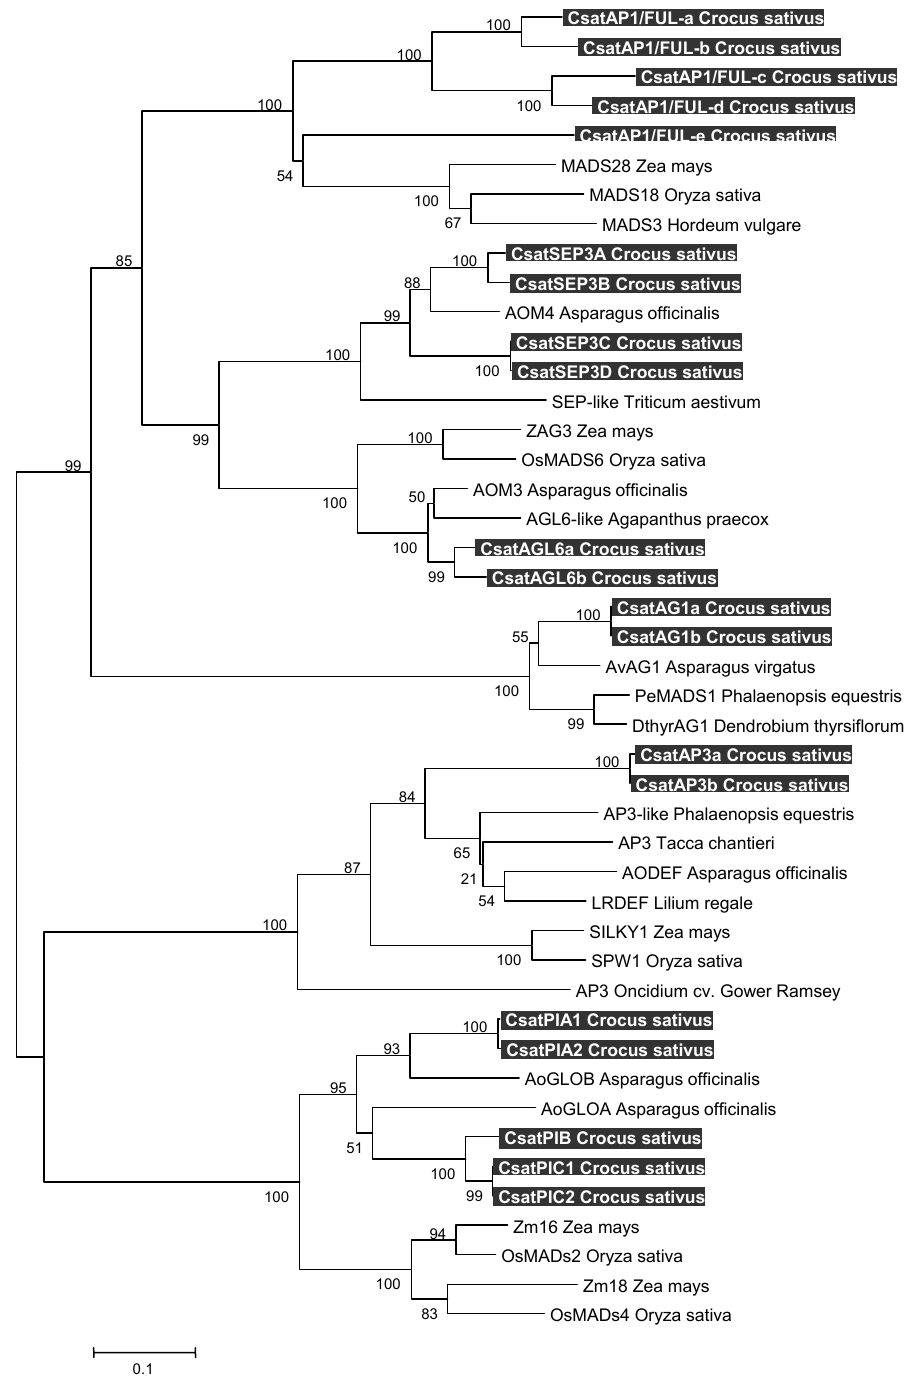
FIGURE 3 Phylogenetic relationships of MADS-box proteins of crocus and related monocots. Amino acid sequences were aligned with Clustal W [42]. The tree was generated by the Neighbor-Joining method using the p-distance correction. Numbers next to the nodes are bootstrap values from 1000 replications. The scale indicates amino acid